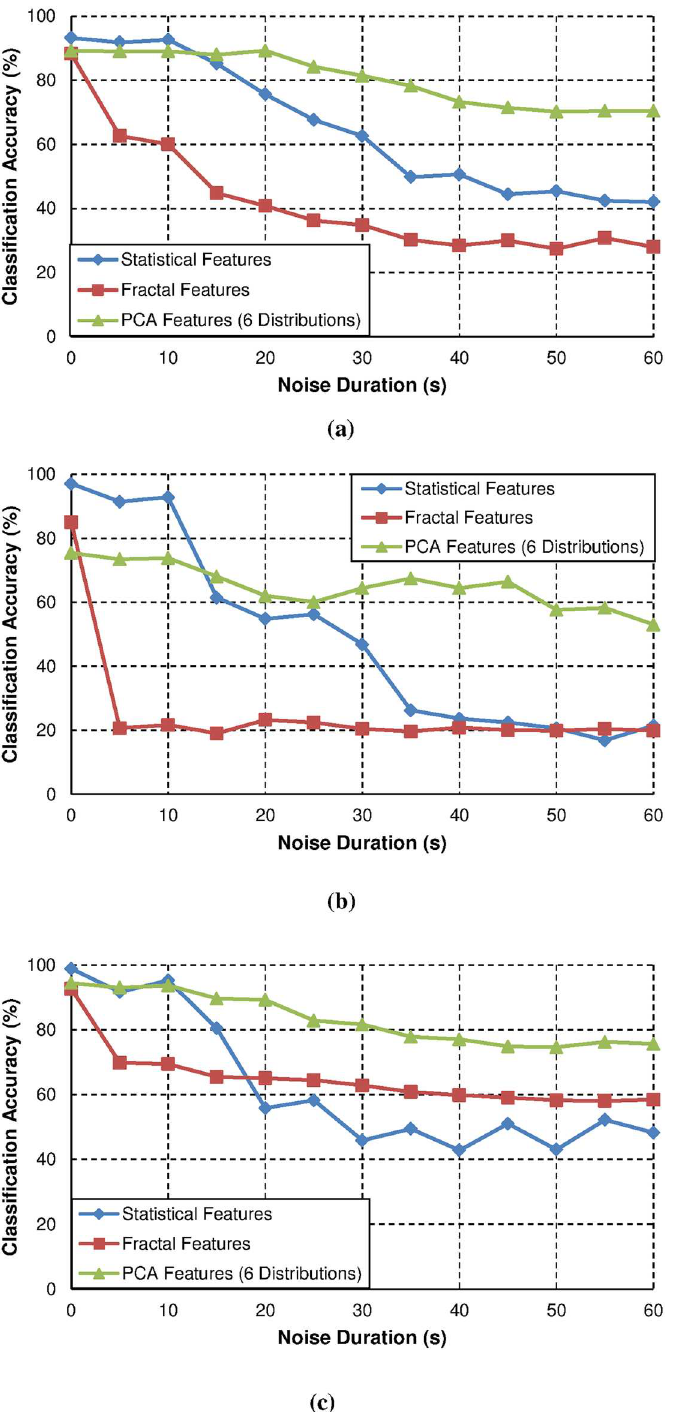
Fig 5. Noise tolerance of; (a) ANN, (b) ANFIS, and (c)